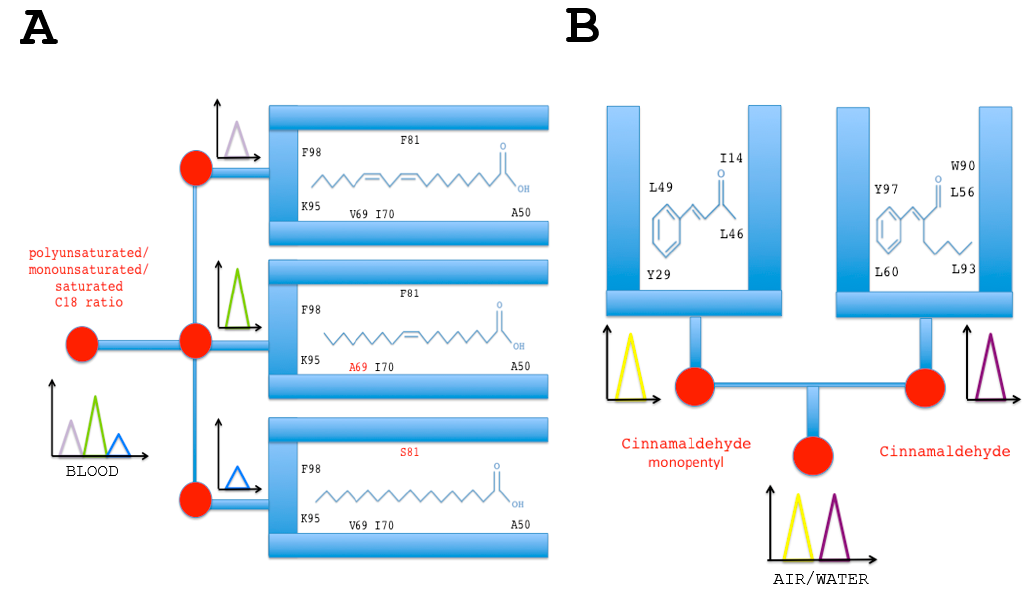
Figure 4. Lipid and insecticide (cinnamaldehyde) chemo-sensor chips based on functional group binding sites of B. tabaci CSPs. ( A ) Sensors based on the interaction of CSP protein with lipids. Specific mixtures of polyunsaturated (linoleic acid), monounsaturated (oleic acid) and unsaturated (stearic acid) lipids will attach luminescent variant CSP protein isoform probes immobilized on the chip. Amino acid in red indicates specific missense mutation in the binding site of BtabCSP1 [14,16]. Lipid-CSP pairing interaction and activation of variant functional binding sites recruit the various forms of fatty acid (polyunsaturated, monounsaturated and saturated) to the biosensor surface, prelude to signal transduction. The sum of the three fluorescent signals is diagnosis for the presence and concentration of each lipid species, thereby providing the lipid basis along with the ratio of the total lipid composition in any relevant biological sample; ( B ) Sensors based on the interaction of CSP with cinnamaldehyde and a cinnamaldehyde chemical derivative (cinnamaldehyde monopentyl). The functional binding sites immobilized on the insecticide chip are those identified for BtabCSP2 and BtabCSP3 [16]. The signals diagnose the presence of different combinations of cinnamaldehydes and measure their levels in the environment.